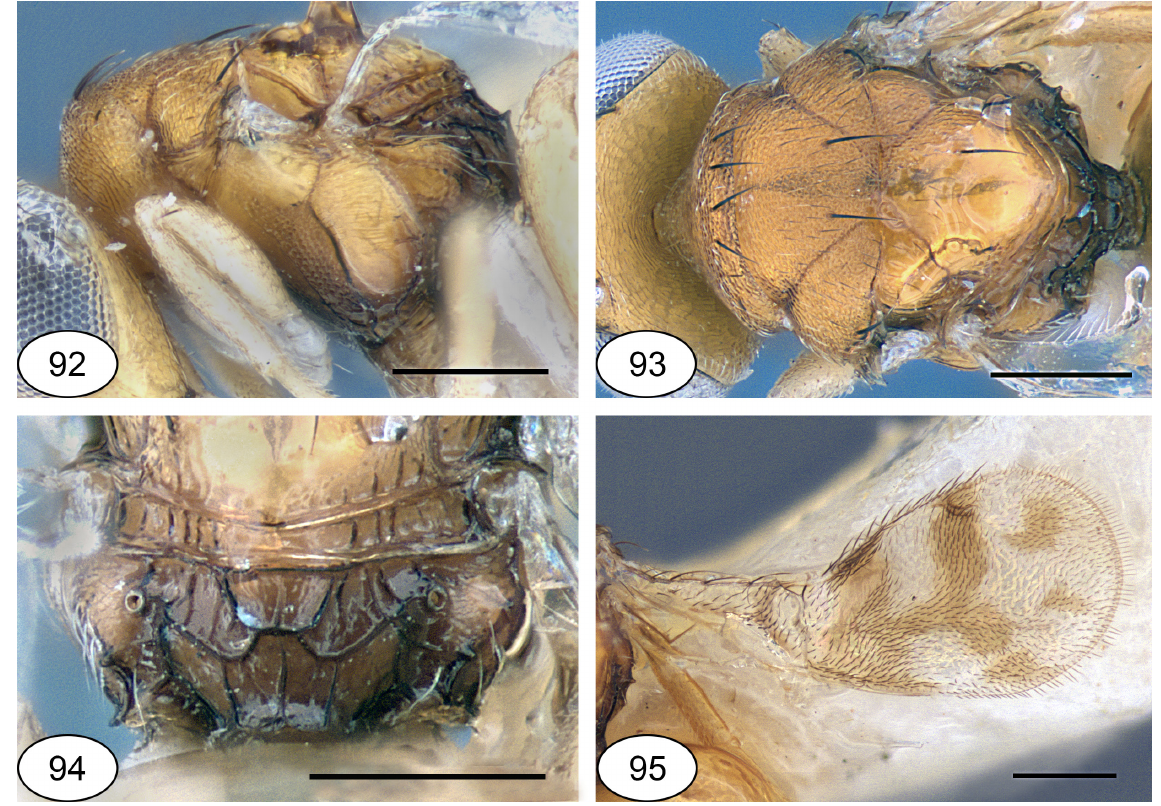
Figs 92–95. Netomocera irregularis sp. nov., holotype, ♀. 92 . Mesosoma, lateral view. 93 . Mesosoma, dorsal view. 94 . Propodeum, dorsal view. 95 . Fore wing. Scale bars: 0.2